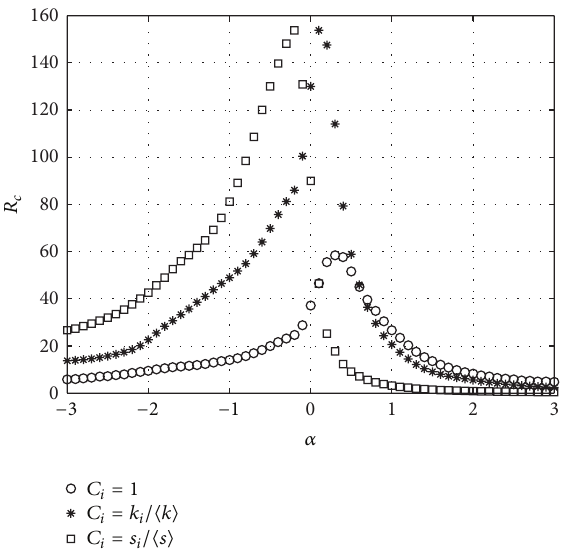
Figure 4: 𝑅 𝑐 versus 𝛼 . BBV network with 𝑛 = 2000 , 𝛿 = 6 , 𝑚 = 6 , and 𝜔 0 = 1